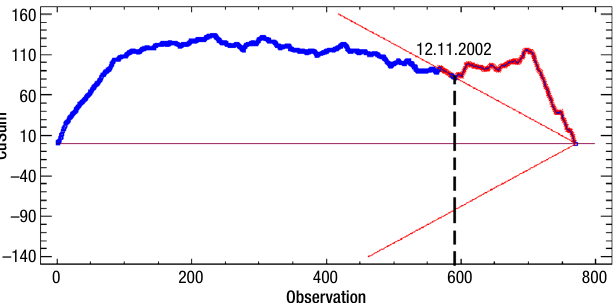
Fig. 11. CUSUM chart for time series of the Overnight Slovak crown during the period